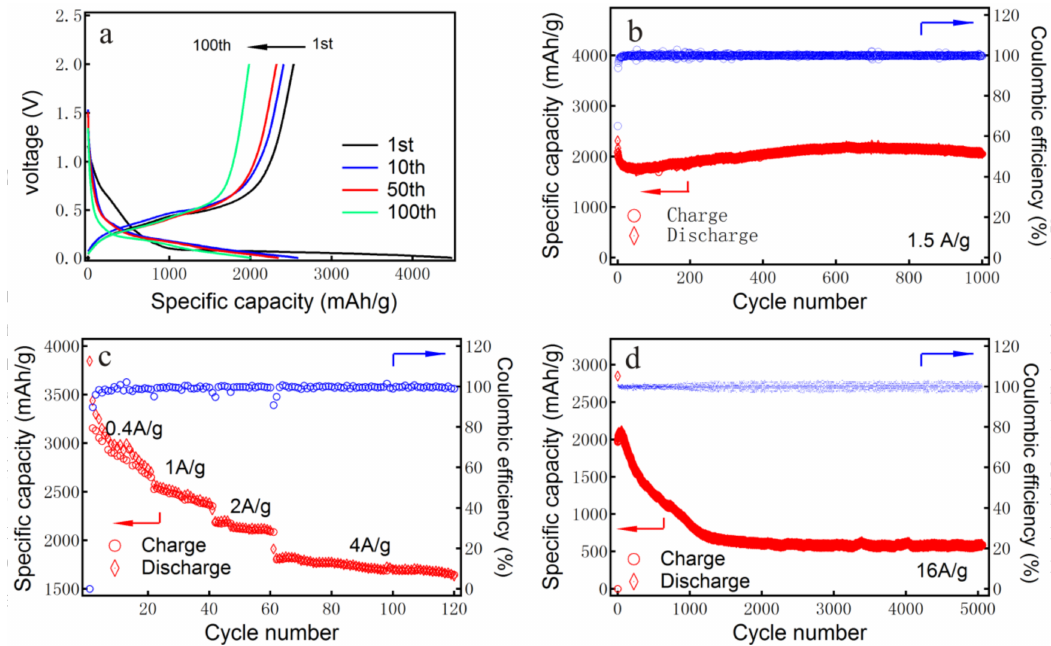
Figure 7. Results of electrochemical performance for 1D–PSiNW anodes. ( a ) Galvanostatic charge/discharge profiles between 0.01 V and 2.0 V vs. Li/Li + for the first, 10th, 50th, and 100th cycles at a current density of 1.0 A · g − 1 . ( b ) Cycling performance of the as-prepared 1D–PSiNW anodes at a current density of 1.5 A · g − 1 . ( c ) Rate performance of 1D–PSiNW anodes at the current density of 0.4/1.0/2.0/4.0 A · g − 1 . ( d ) Electrochemical performance of 1D–PSiNW anodes with 5000 cycles at a current density of 16.0 A · g − 1